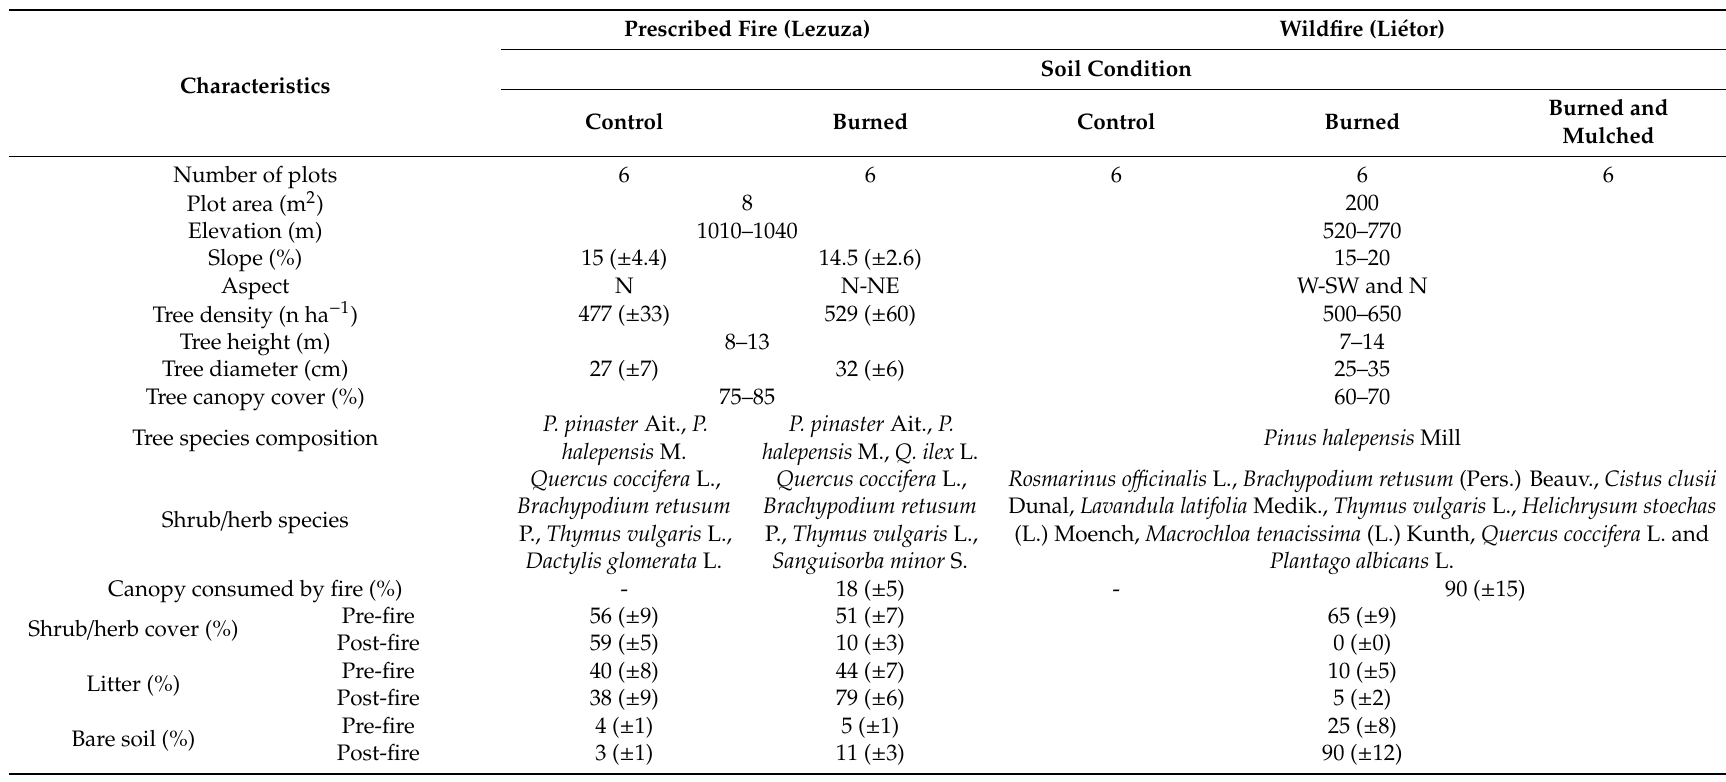
Table 1. Main characteristics of forests and plots subject to prescribed fire and wildfire (Lezuza and Li é tor, Castilla La Mancha, Spain).